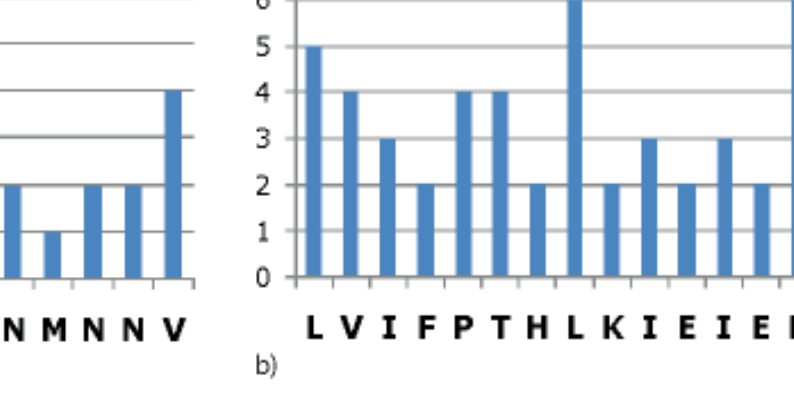
Figure 10. Hit05 and 06 logos with promoter